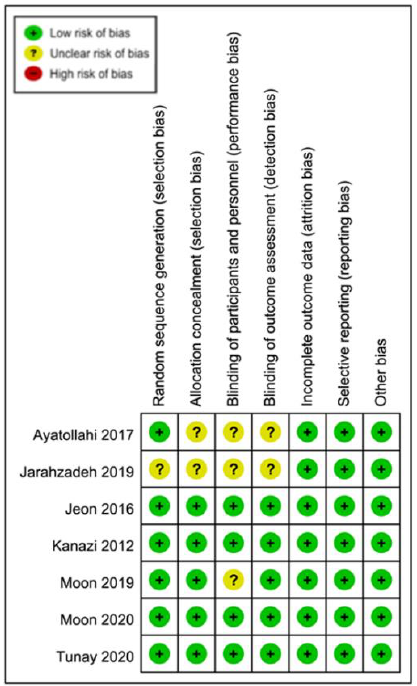
Figure 2. Risks of bias of individual studies.